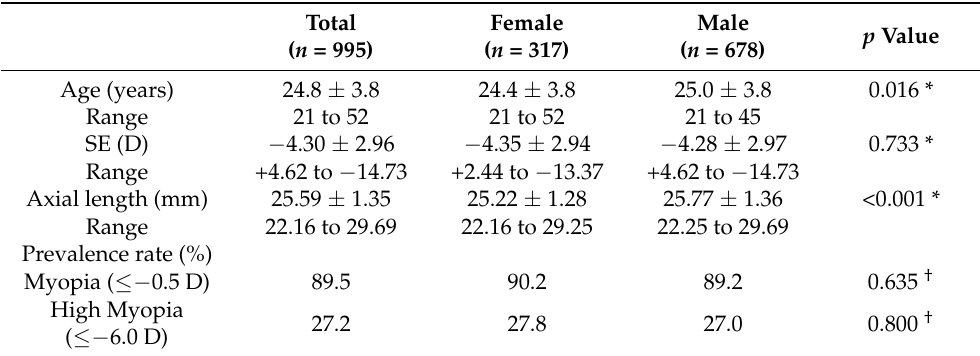
Table 1. Prevalence rates of myopia and high myopia. * Unpaired t -test; † chi-square test. SE, spherical equivalent; D,